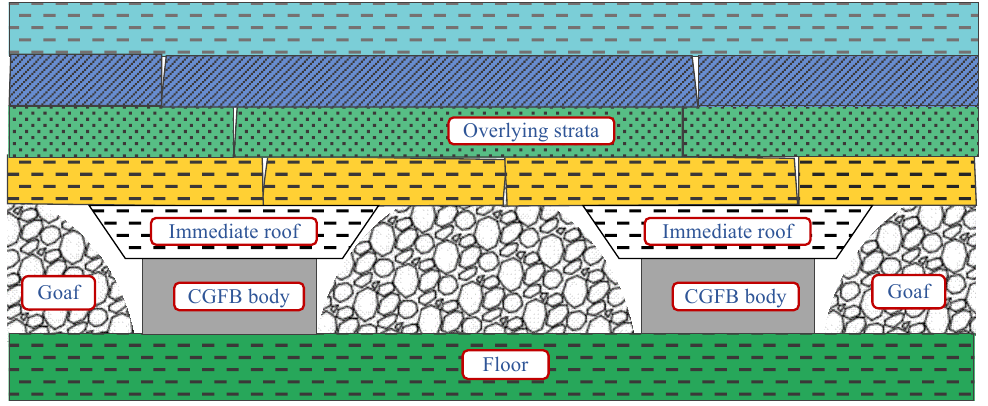
Figure 1. Basic principle of strip-filling mining [7].